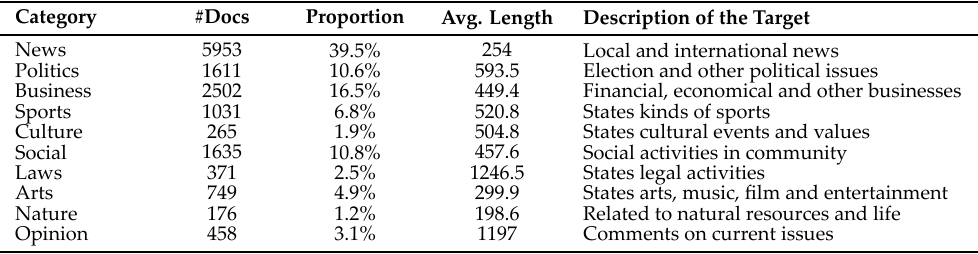
Table 2. Topic Modeling Amharic Corpora Description